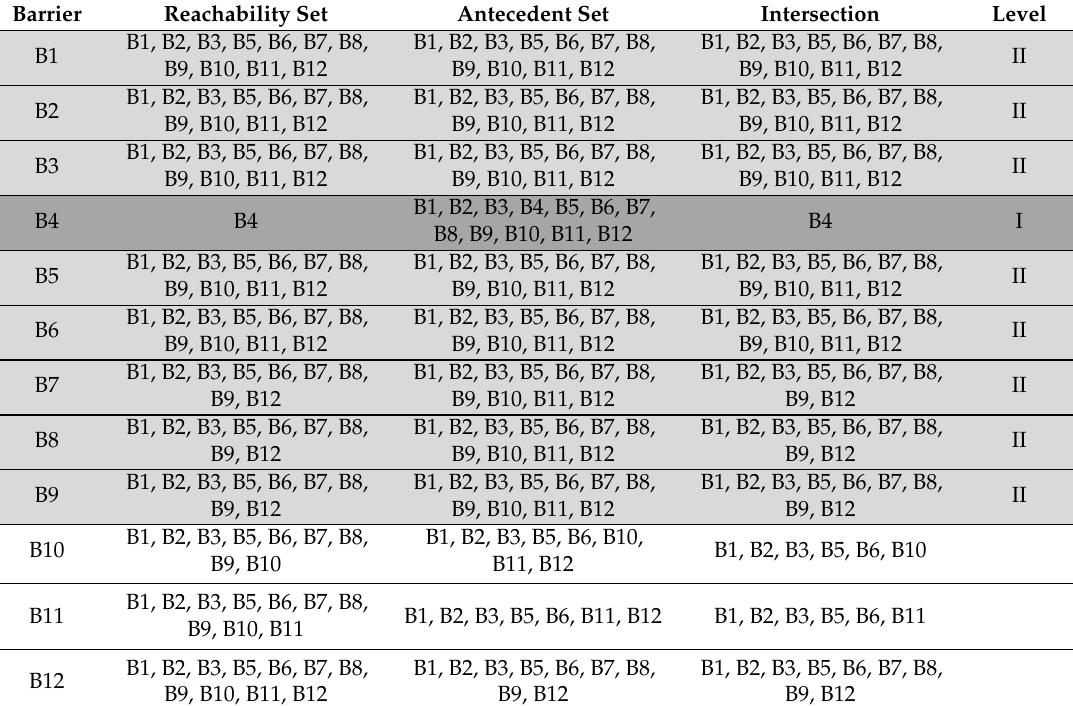
Table 6. Partition matrix (PM) and barrier (B1–B12) levels—2nd iteration of ISM computations. Barrier Reachability Set Antecedent Set Intersection